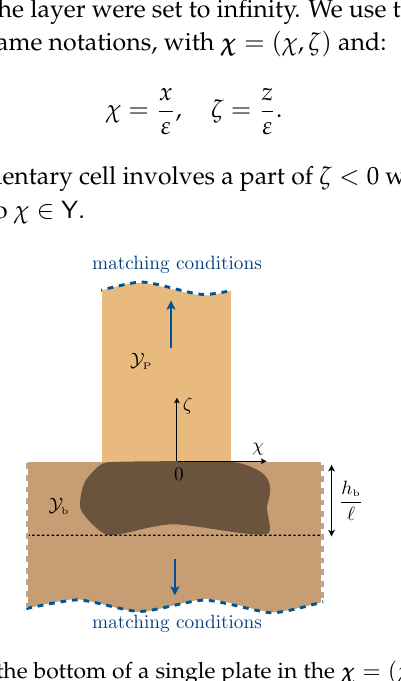
∞ ,0 ) Y = ( h χ , and ; ϕ / (cid:96) is the non-dimensional surface b b } Y b { ∈ × − } / (cid:96) b